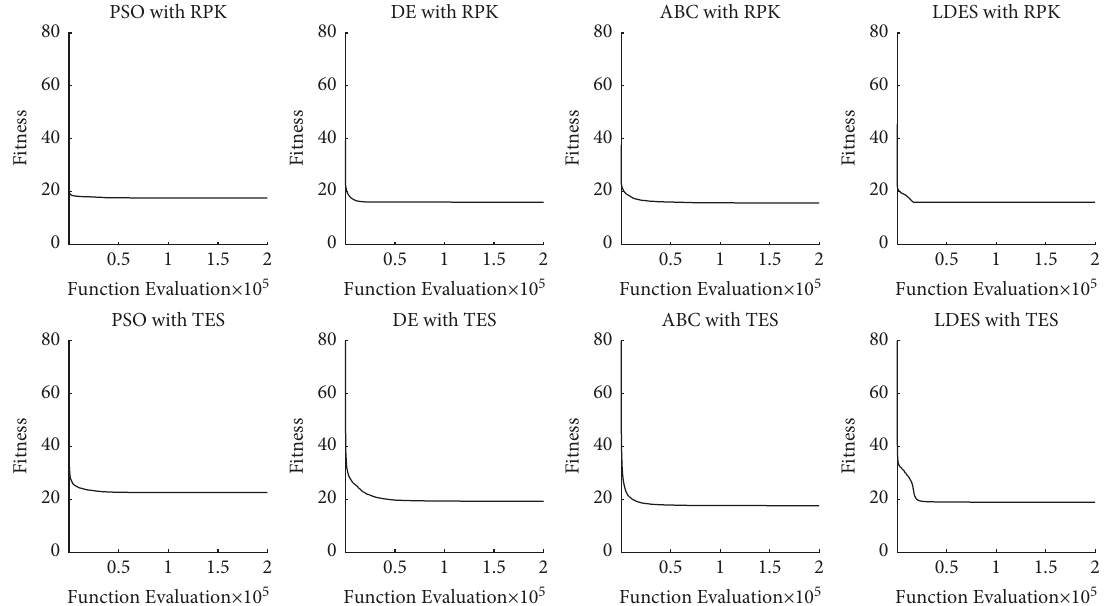
Figure 7: Convergence curves of PSO, DE, ABC, and LDES using RPK and TES encoding scheme.